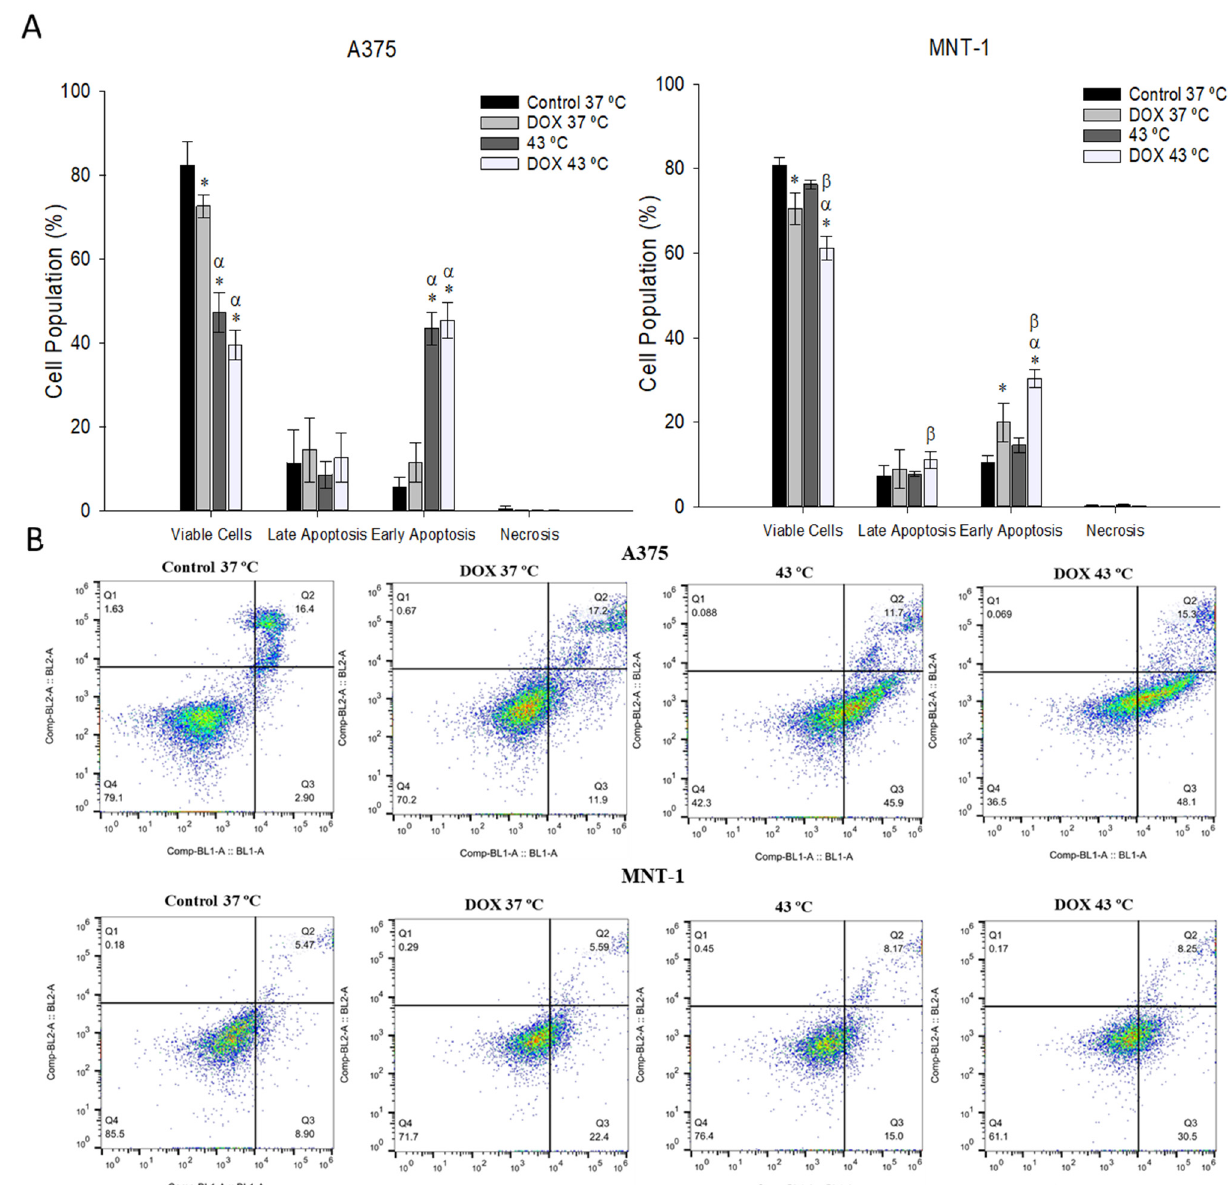
Figure 6. Effects of hyperthermia in combination with DOX on apoptotic profile. Both cell lines were exposed to 43 °C for 30 min and A375 cells were treated with 0.0125 μ M and MNT-1 cells with 0.0179 μ M of DOX for 48 h. ( A ) Percentage of apoptotic cells after treatment in populations corresponding to viable and non-apoptotic, early and late apoptotic A375 and MNT-1 cells; ( B ) histograms repre- sentative of Annexin V-FITC. Data shown are mean values ± standard deviation of two independent experiments with two technical replicates each and each replicate with at least 5000 events. *— in- dicates statistical significance in comparison to the control 37 °C; α indicates statistical significance in comparison to the respective control of each condition at 37 °C; and β indicates statistical signifi- cance of the combined treatment in comparison to hyperthermia alone ( p < 0.05).